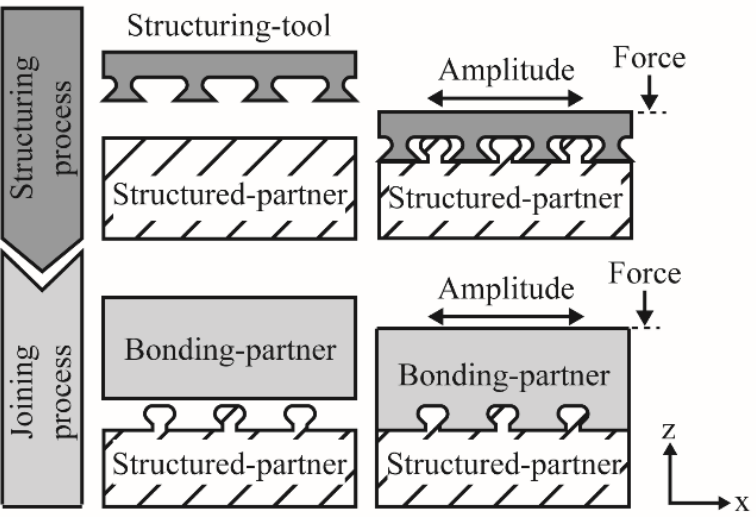
Figure 1. Process schema of the form ‐ fit joining using pin ‐ like structures in the vibration welding process [13].